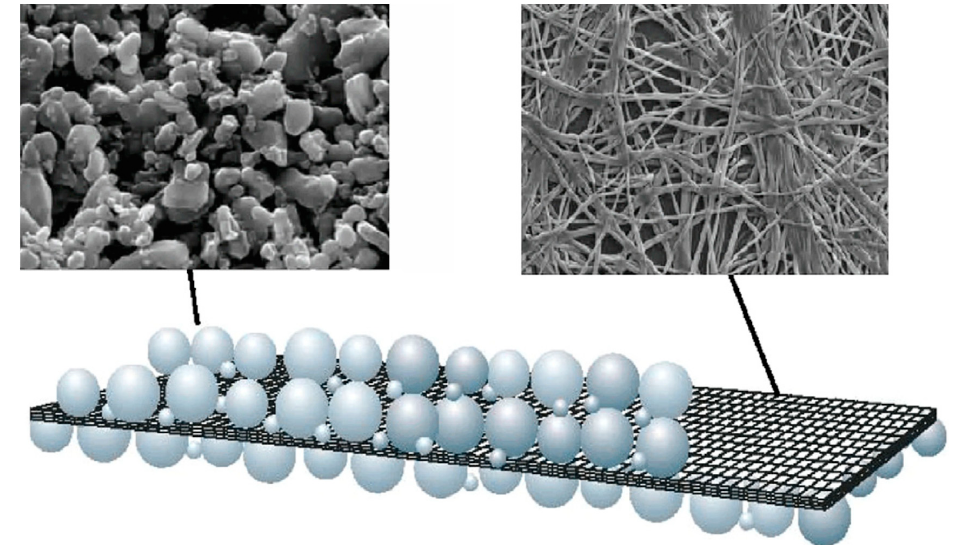
Figure 17. This commercially available separator have good wettability, superior chemical resistance and very low shrinkage at high temperatures [18]. Appl. Sci. 2017 , 7 , 731